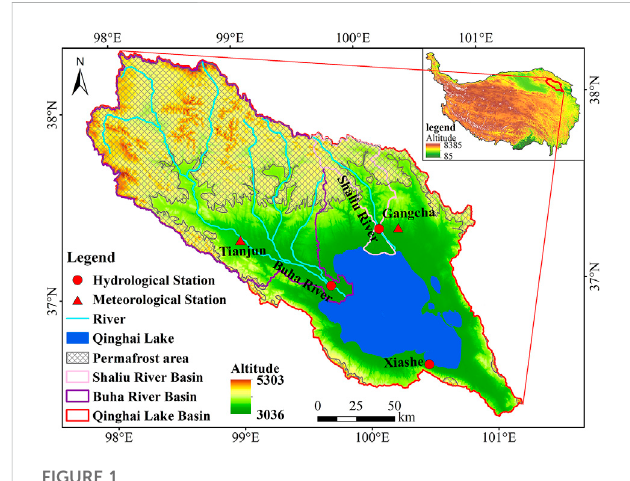
FIGURE 1 Geographical location and drainage map of Qinghai Lake